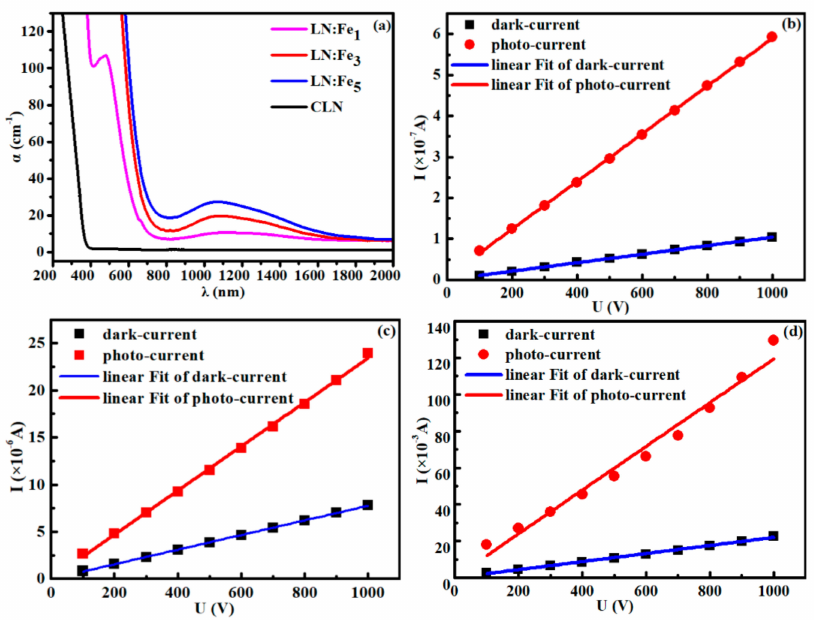
Figure 1. ( a ) The absorption spectra of y-cut LN:Fe and CLN, ( b – d ). The current versus voltage (I-U) curves of ( b ) LN:Fe 1 , ( c ) LN:Fe 3 , and ( d ) LN:Fe 5 blocks, the dark-current in a dark room, and the photo-current with the optical intensity at λ = 473 nm were measured,